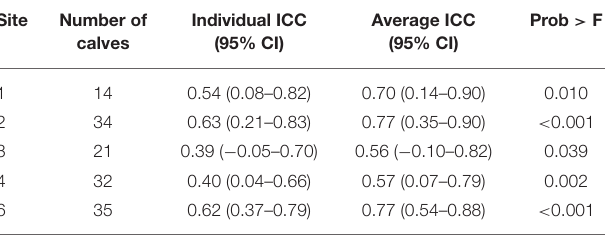
TABLE 3 | Intra-operator reliability for MNT measured using pressure algometry over the thoraces of calves. Site Operator Number of calves